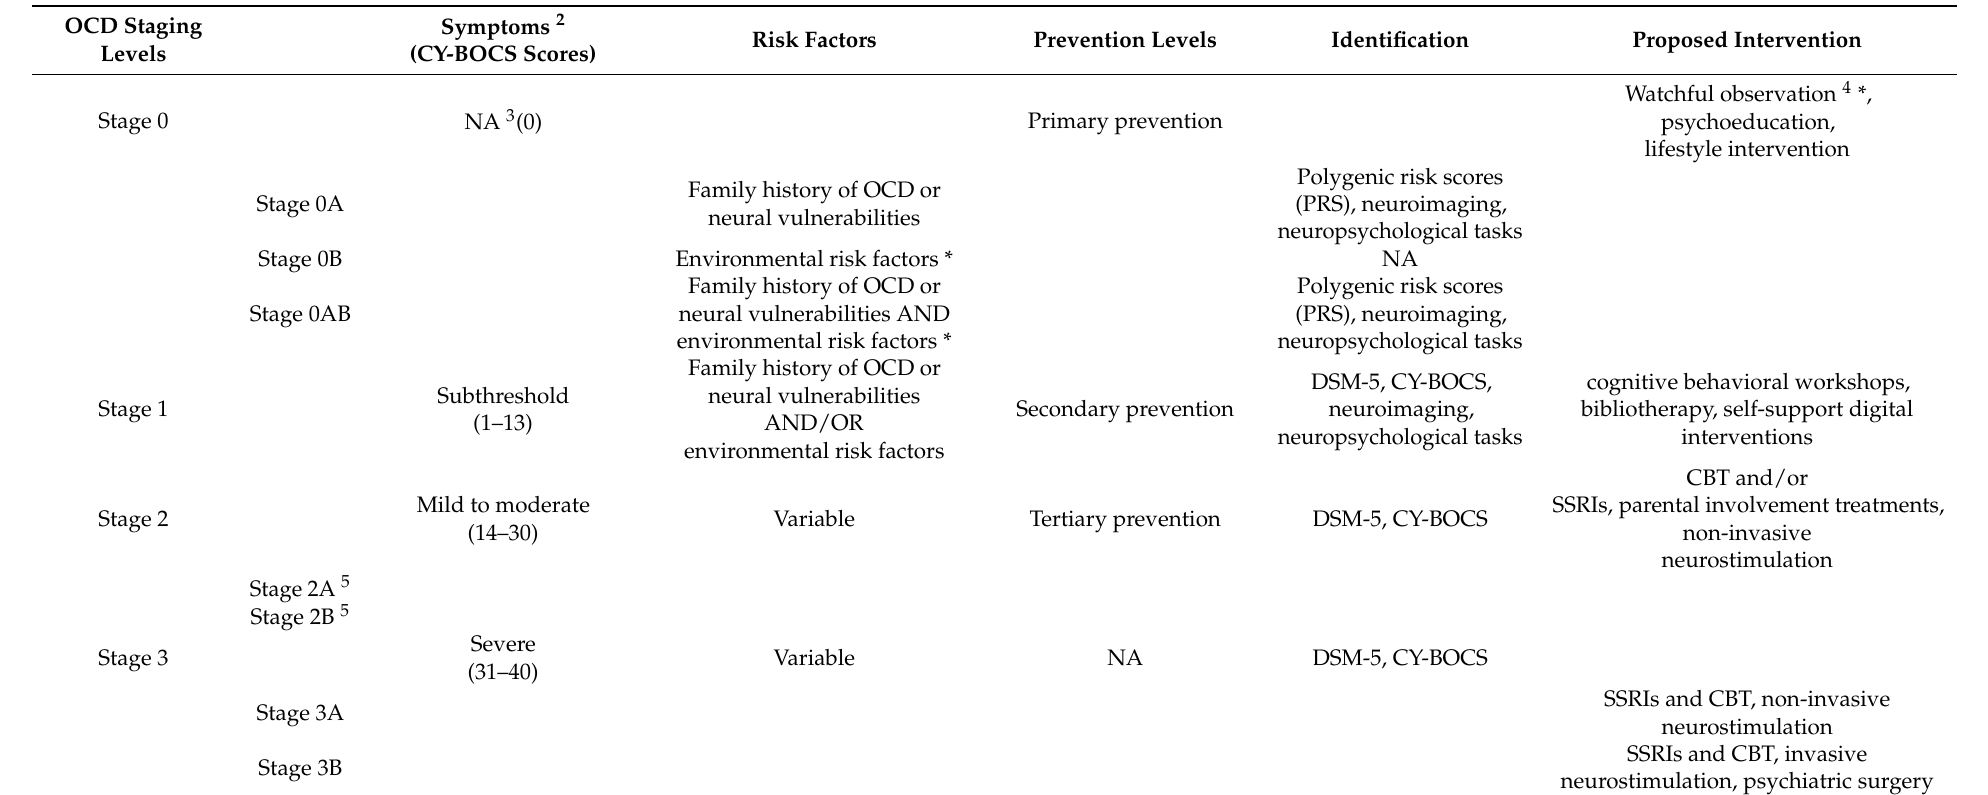
Table 1. Primary, secondary and tertiary prevention corresponding to the clinical staging models of pediatric OCD 1